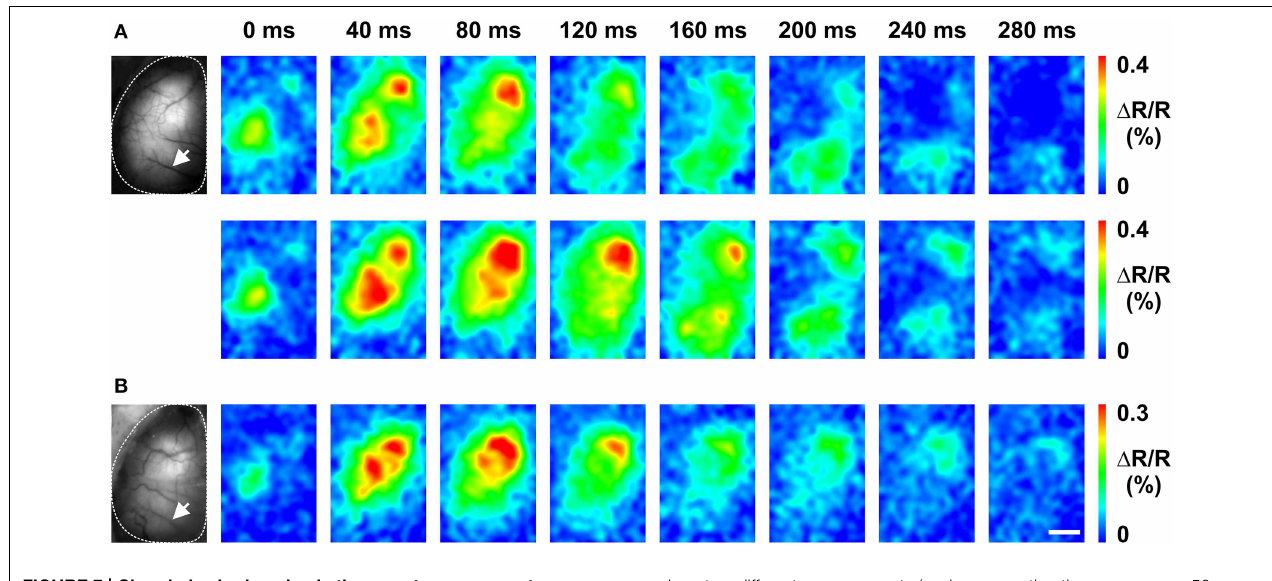
show two different measurements (each representing the average over 50 trails) recorded on the same day. (B) Imaging session performed at P176, otherwise as in (A) . White arrows in (A,B) indicate the same blood vessels. The transcranial window was prepared at P120. Scale bar,